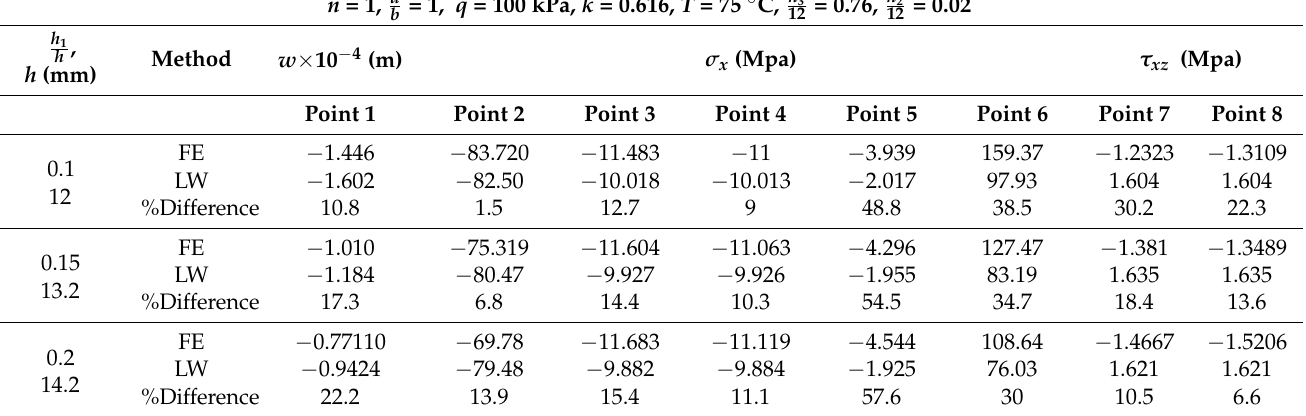
Table 10. Comparison of the result based on LT and those FE findings.